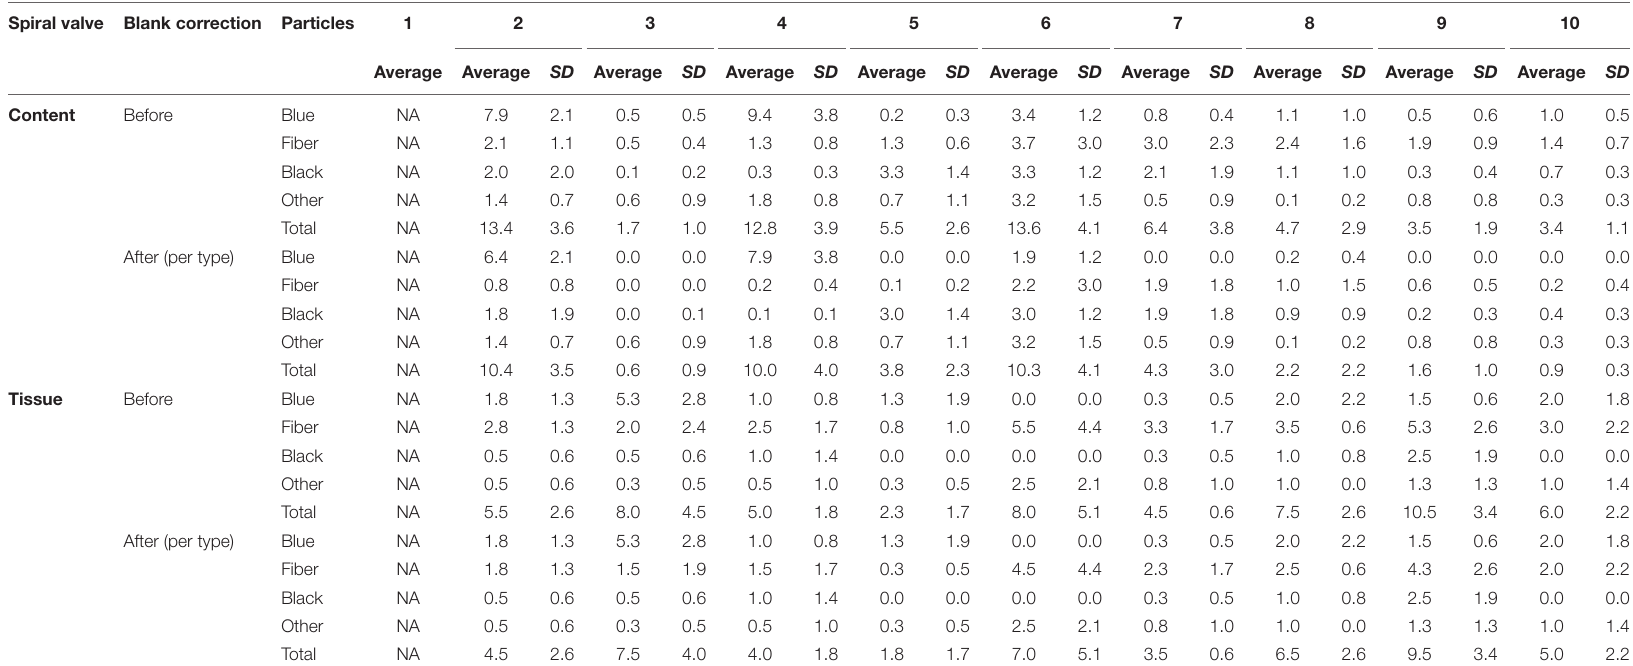
TABLE 2 | The number of plastic particles in spiral content and tissue, expressed as average* number of plastic particles per g w.w. before and after blank correction (per type); SD, Standard Deviation; NA, Not Available; *5 content and 4 tissue replicates per spiral valve. Spiral valve Blank correction